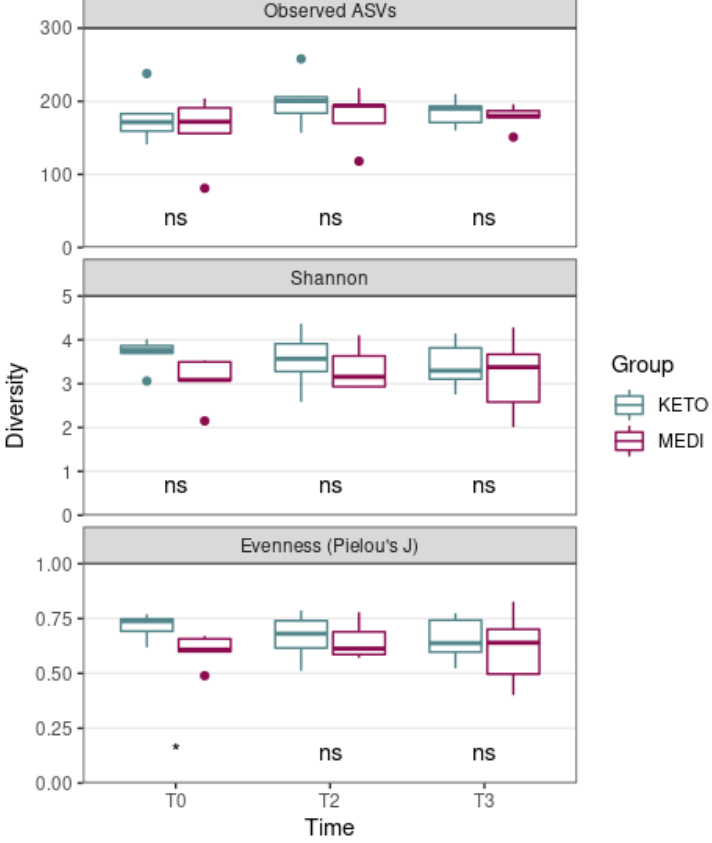
Figure 2. Gut microbiota alpha diversity comparison between diets at each time point. Each subplot concerns a different alpha diversity metric (Observed ASVs, Shannon, or Pielou’s J). The boxes highlight the median value and cover the 25th and 75th percentiles, with whiskers extending to the more extreme value within 1.5 times the length of the box. Statistical significance was evaluated by the Mann–Whitney U test, and it was indicated as follows: ns, non-significant; *, p ≤ 0.05. KETO = 6 patients who followed a very-low-calorie ketogenic diet (VLCKD), MEDI = 5 patients who followed a low-calorie Mediterranean diet